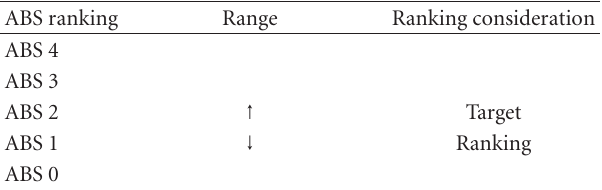
Table 5: Journals: ranking and